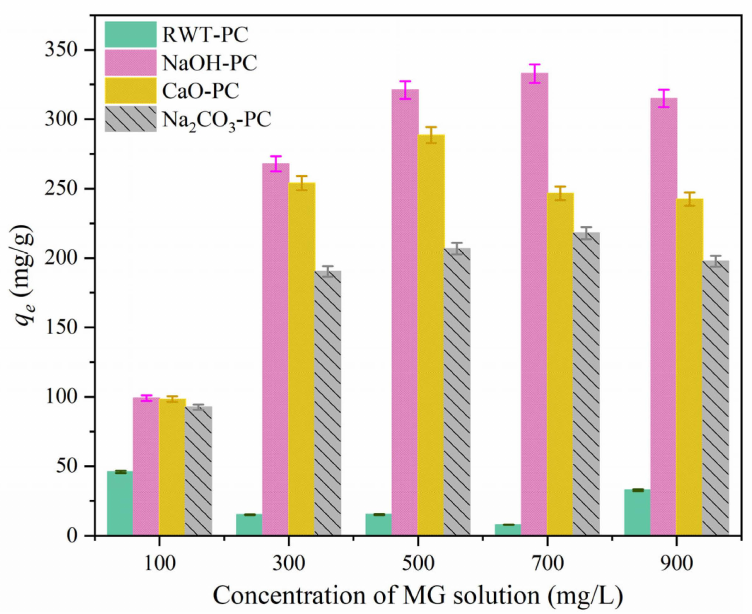
Figure 7. Effect of initial malachite green (MG) concentration on MG dye adsorption capacity (Dosage = 40 mg and T = 301